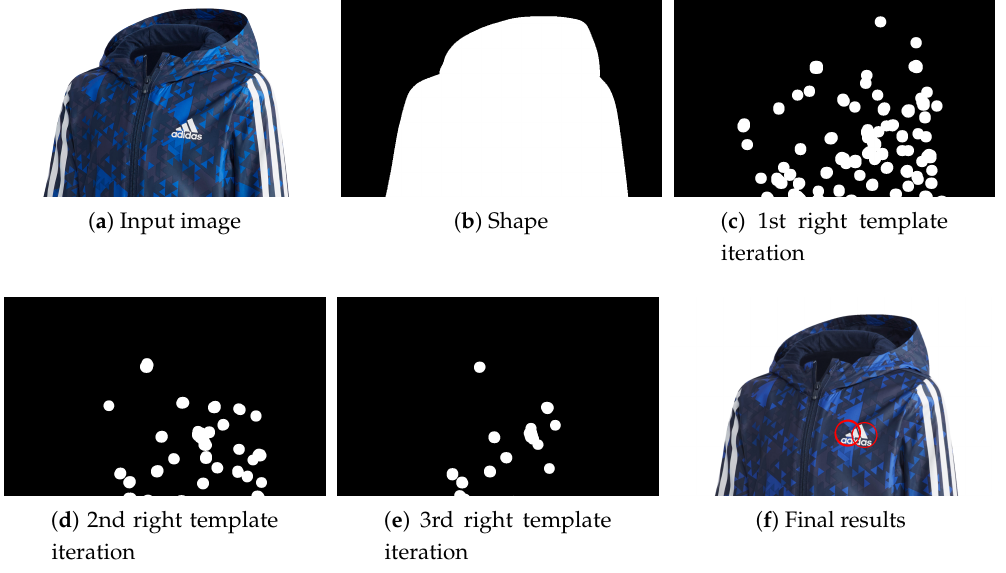
Figure 8. An example of logo detection using template